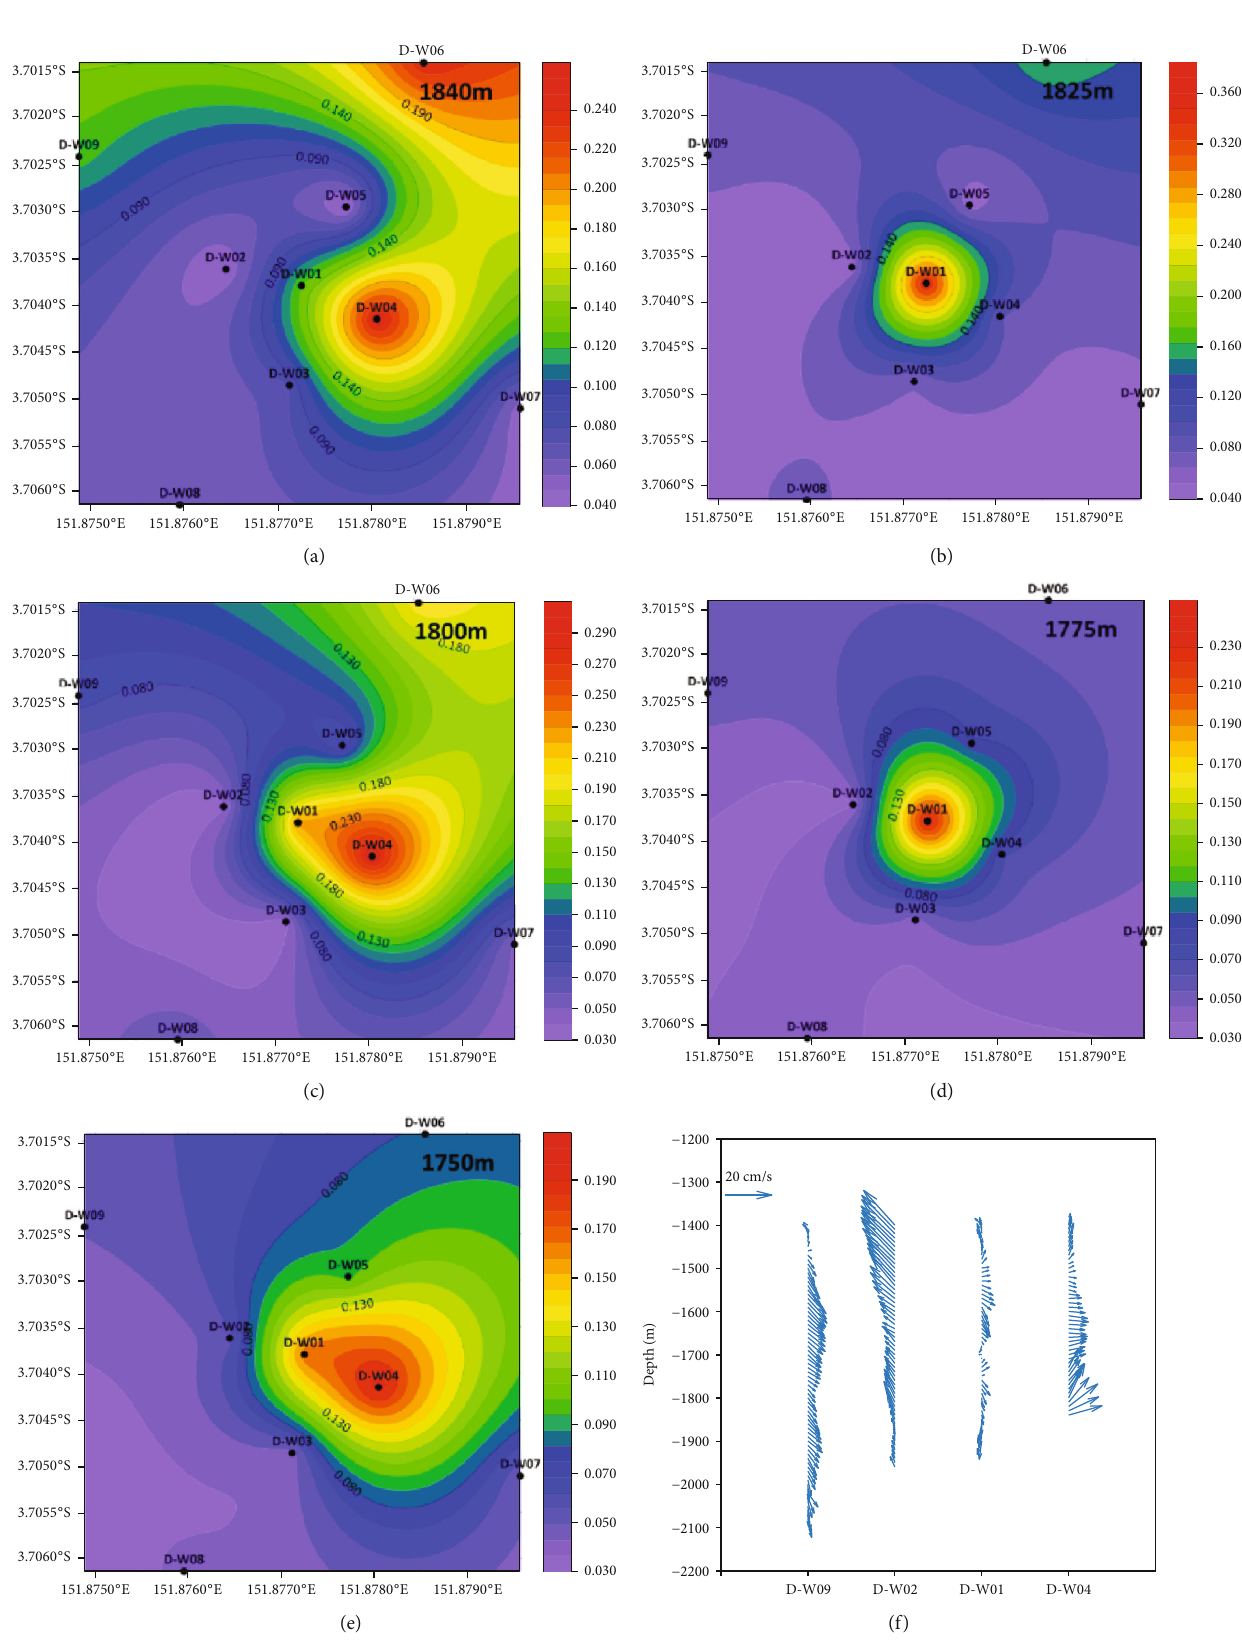
Figure 5: Turbidity contour and current velocity map of the Desmos hydrothermal fi